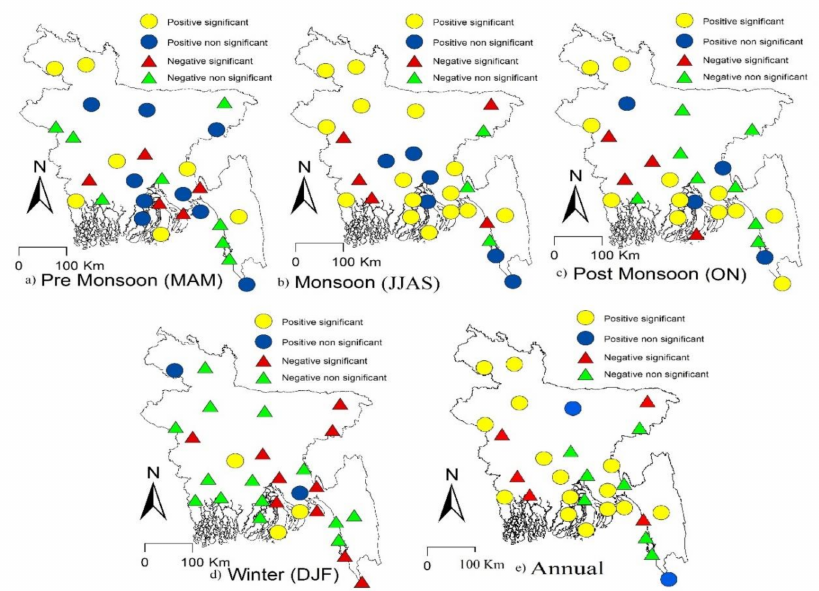
Figure 8. Distributions of the trends in monthly TS days ( a ) premonsoon (March–May (MAM)); ( b ) monsoon (June–September (JJAS)); ( c ) postmonsoon (October–November (ON)); ( d ) winter (December–February(DJF)); ( e ) annual in Bangladesh during 1975–2016. Positive significant (insignificant) is shown as yellow (blue) color and negative significant (insignificant) is shown as red (green)